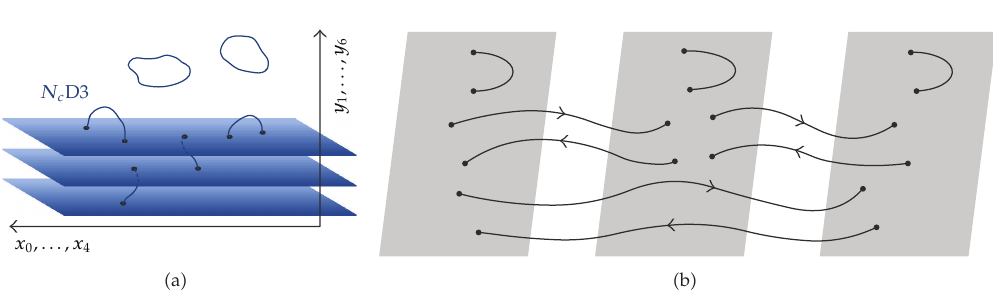
Figure 1: The configurations of N c stack of D3 branes in 10d spacetime. (cid:2) a (cid:3) D3 branes sweep (cid:2) 3 (cid:8) 1 (cid:3) dimensions in (cid:2) 9 (cid:8) 1 (cid:3) space time. (cid:2) b (cid:3) N c (cid:7) 3 stack of D3 branes and all the possible classes of open